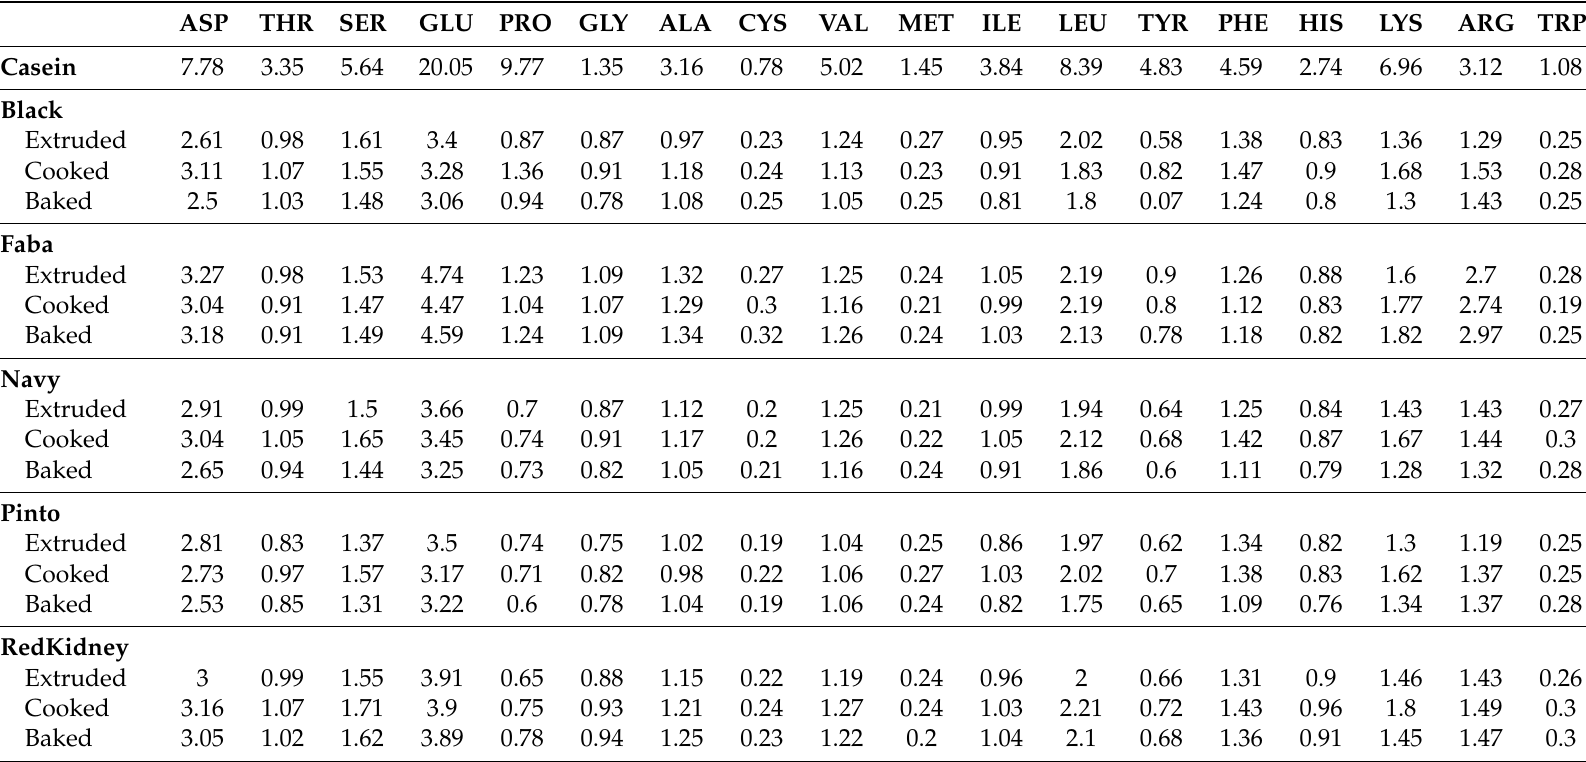
Table 2. Amino acid composition of extruded, cooked and baked